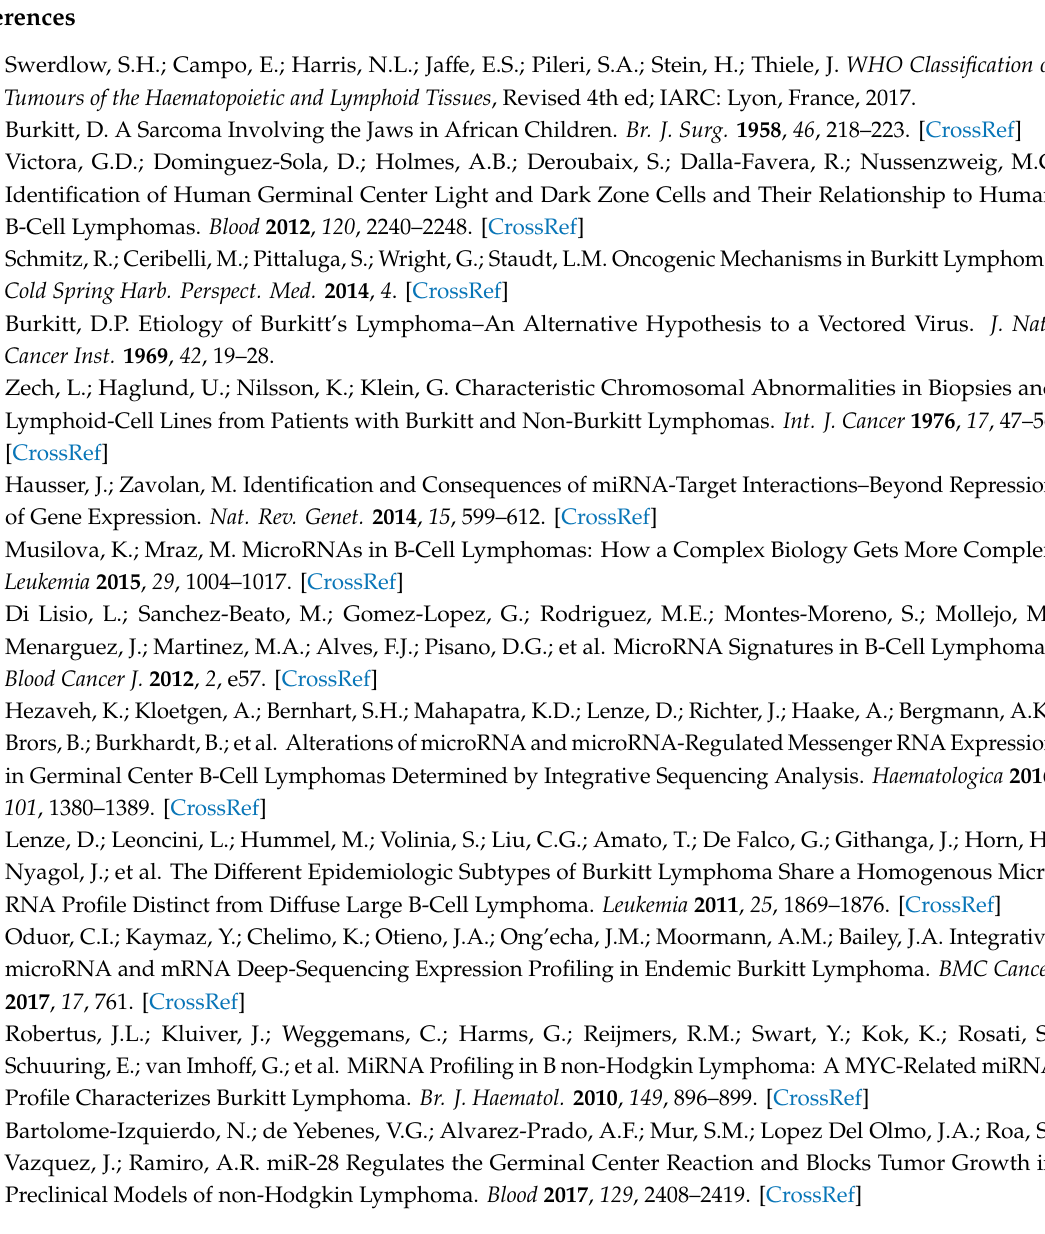
S4: Overview of the 44 miRNA precursors included in the pCDH pool, Table S5: Oligos sequences of sgRNAs. Table S6: Oligos for cloning miR-26b-5p binding sites from selected